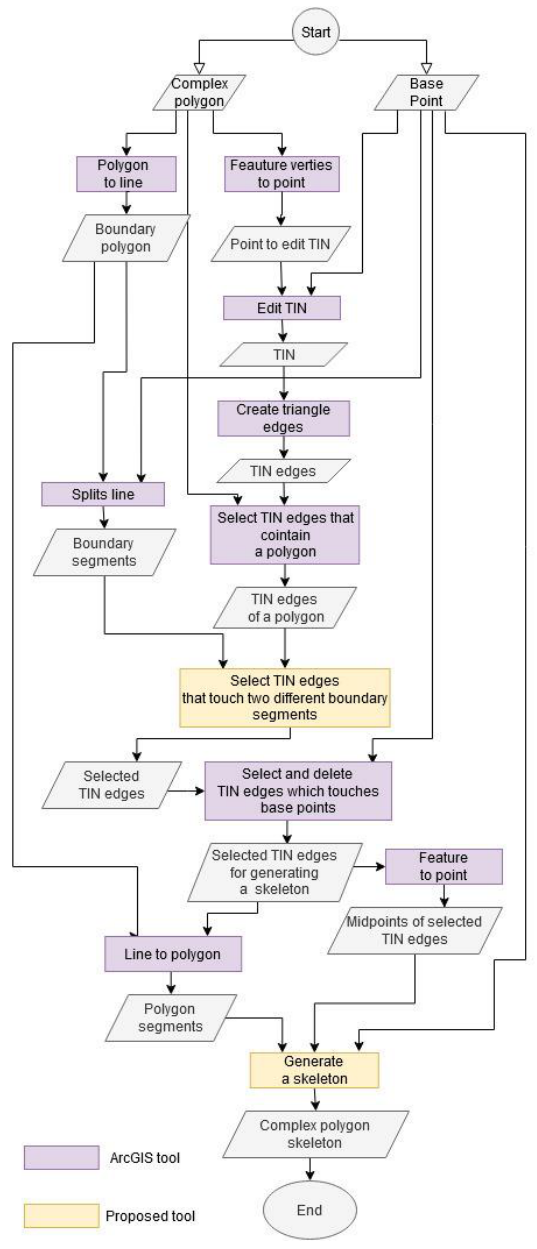
Figure 2. Flowchart of the Base Point Split (BPSplit) algorithm.